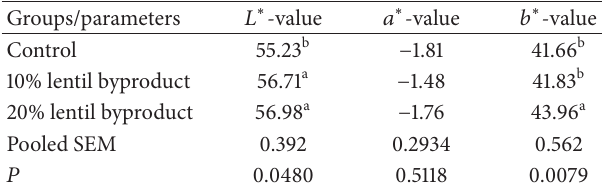
Table 4: The effect of the dietary inclusion of lentil byproduct on yolk color.